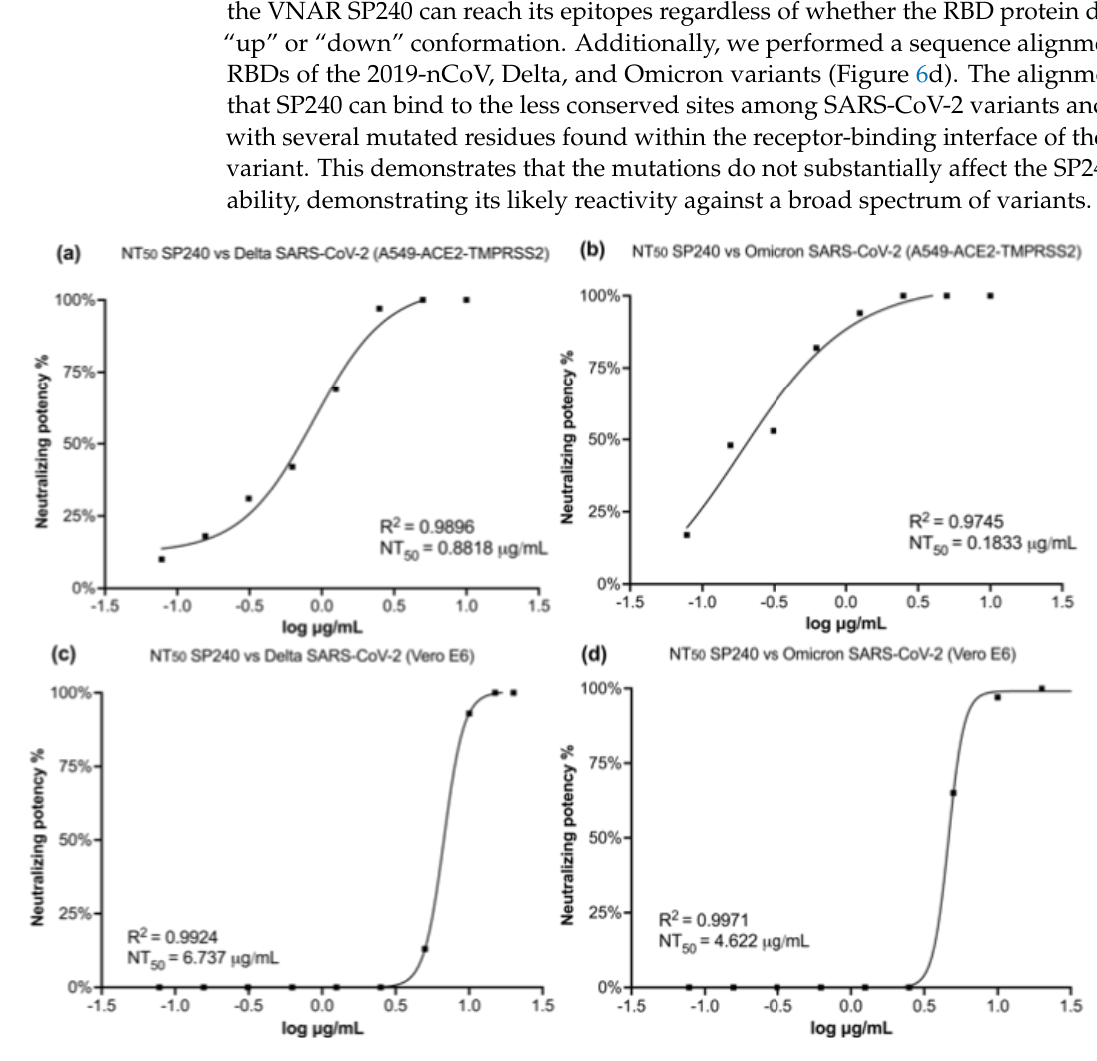
Figure 5. Neutralizing efficiency of Variable New Antigen Receptor (VNAR) SP240 against the SARS-CoV-2 Delta and Omicron variants. Half maximal inhibitory concentration for SARS-CoV-2 neutralization mediated by SP240 in A549-ACE2-TMPRSS2 ( a , b ) and Vero E6 ( c , d ) cells, respectively. SP240 was found to be more efficient in the A549-ACE2-TMPRSS2 cell line compared to the Vero E6 cell line.